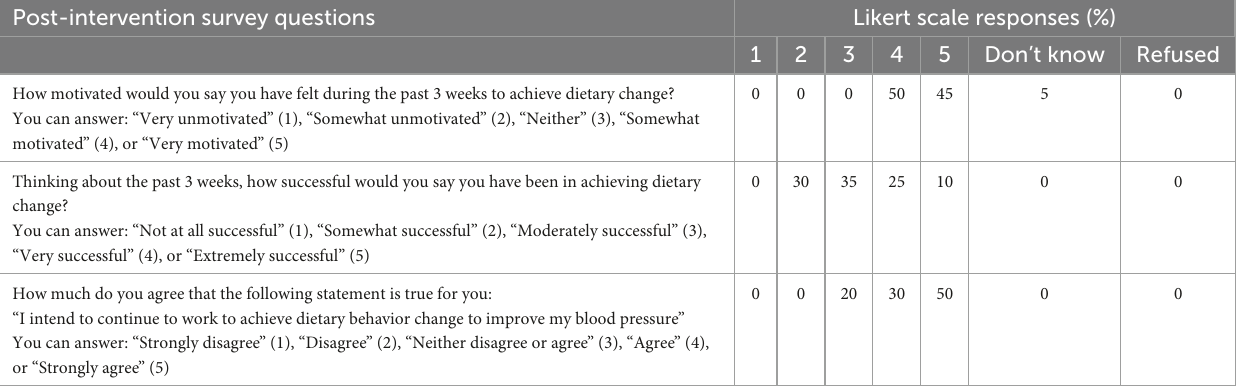
TABLE 3 Participant responses to post-intervention survey questions related to dietary behavior